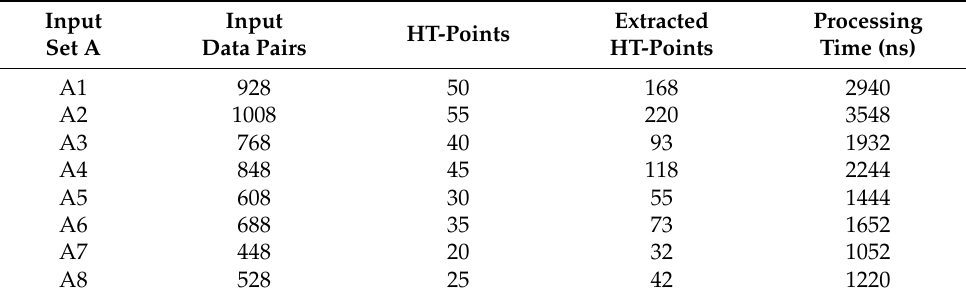
Table 1. Summary table for a VHDL